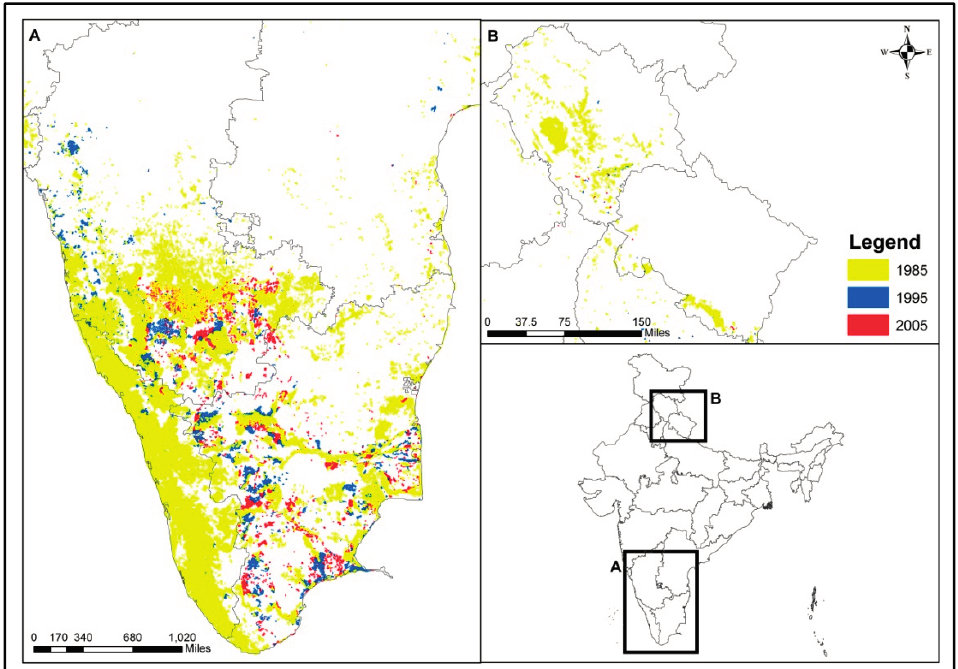
Figure 9. Significant changes in plantation area in Peninsular India and Western Himalaya